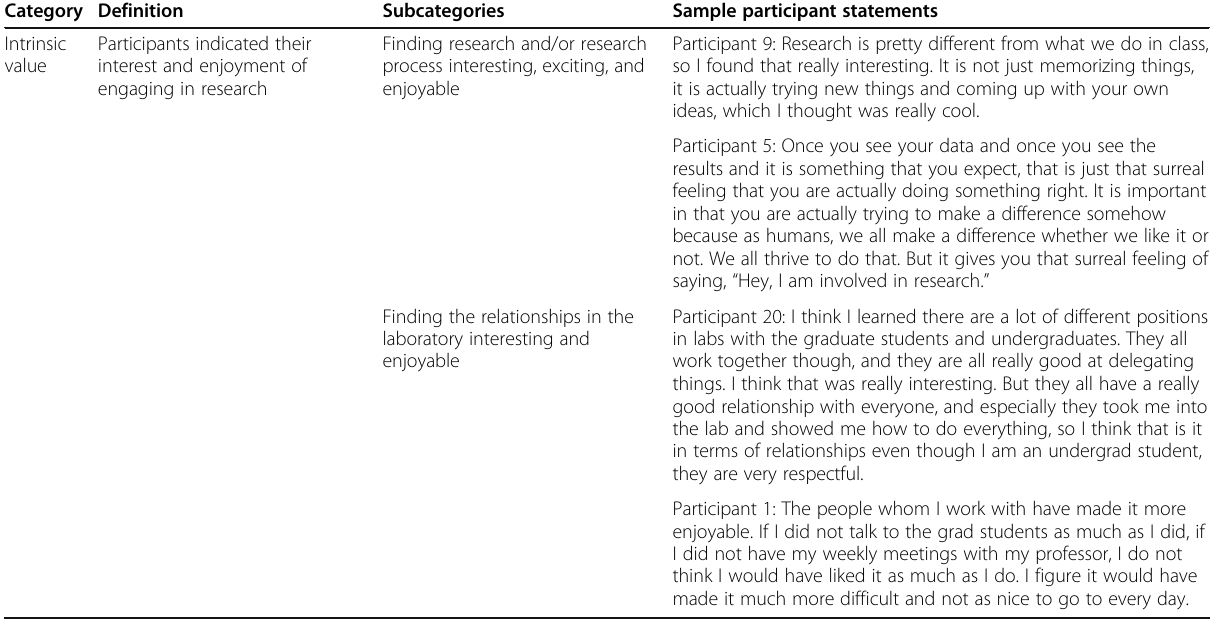
Table 2 Intrinsic value definition and examples of participants ’ statements Category